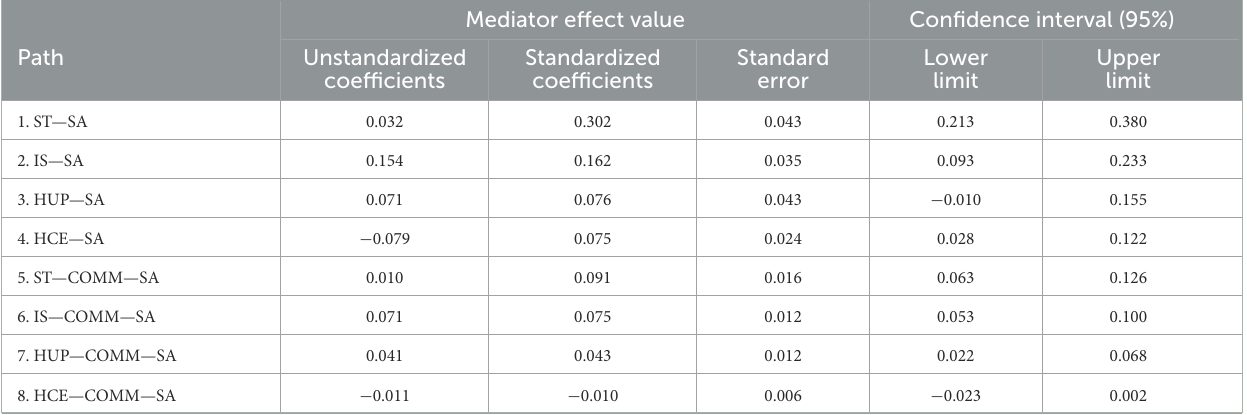
TABLE 5 Effect decomposition and 95% confidence interval of bias-corrected